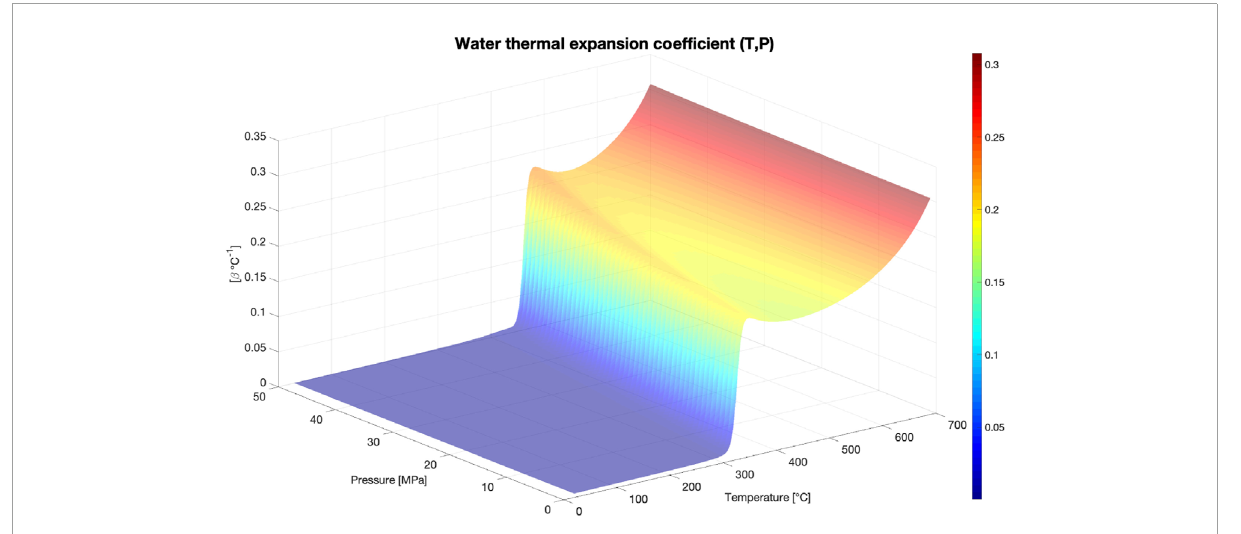
FIGURE 5 Pattern of the implemented thermal expansion coefficient of water [° C −1 ] .